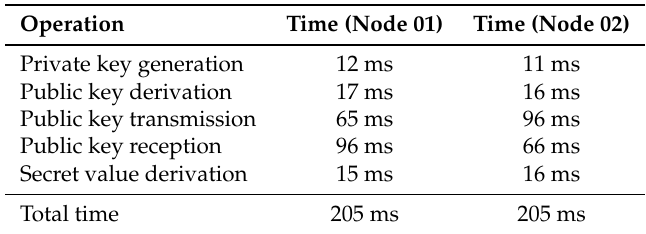
Table 7. Time required for Diffie–Hellman operations between two